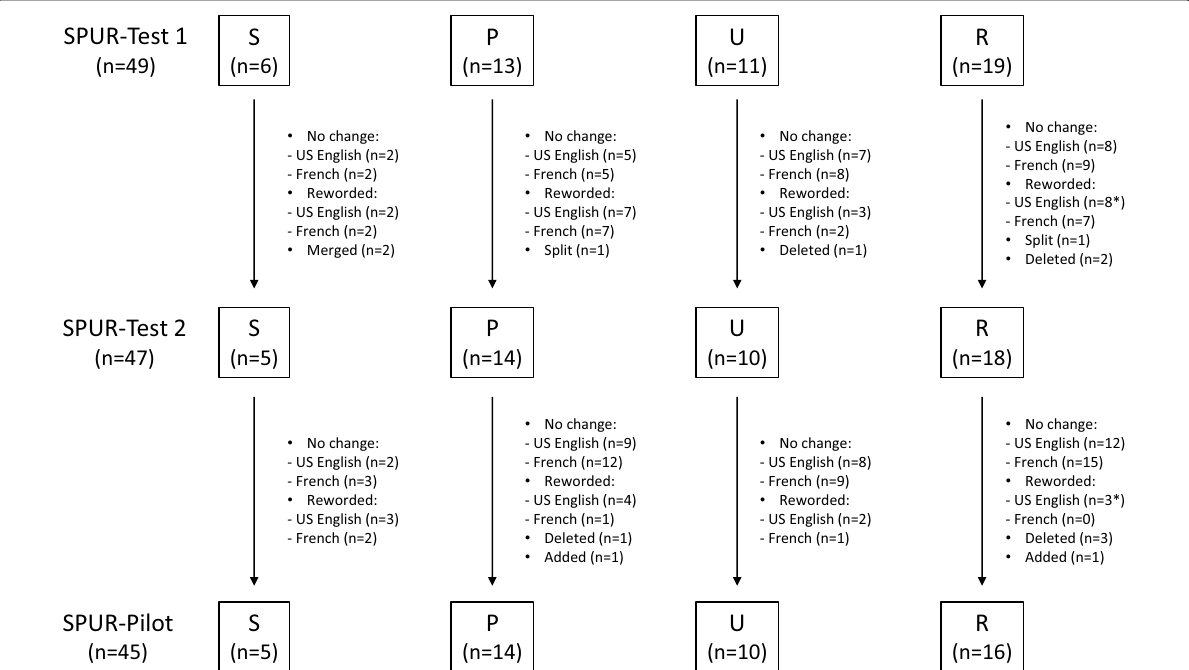
Fig. 3 Evolution of the SPUR tool versions (US English and French). SPUR Social, Psychological, Usage, Rationale, n number of items. *Example of rewording (US English version): SPUR‑Test 1: “Medications should only be taken when needed”; SPUR‑Test 2: “I believe I can stop taking my treatment for my [health problem] when I feel better.”; SPUR‑Pilot: “I believe I can stop my treatment for my [health problem] when I feel